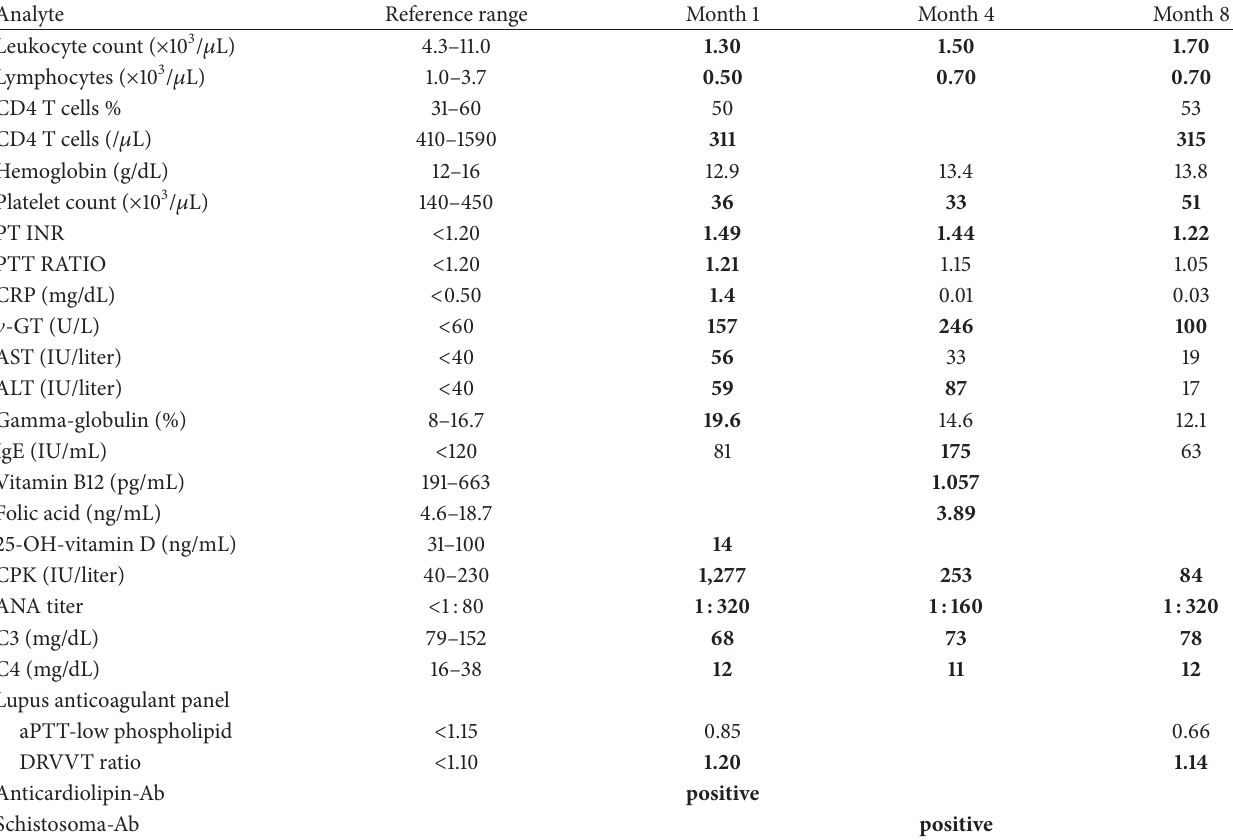
Table 1: Laboratory